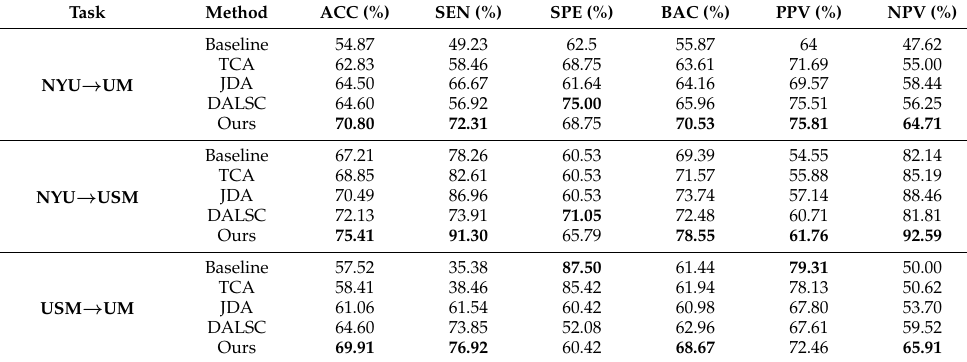
Table 3. Performance of five different methods in ASD classification on the multisite ABIDE database. The number in bold indicates the best result achieved under a certain